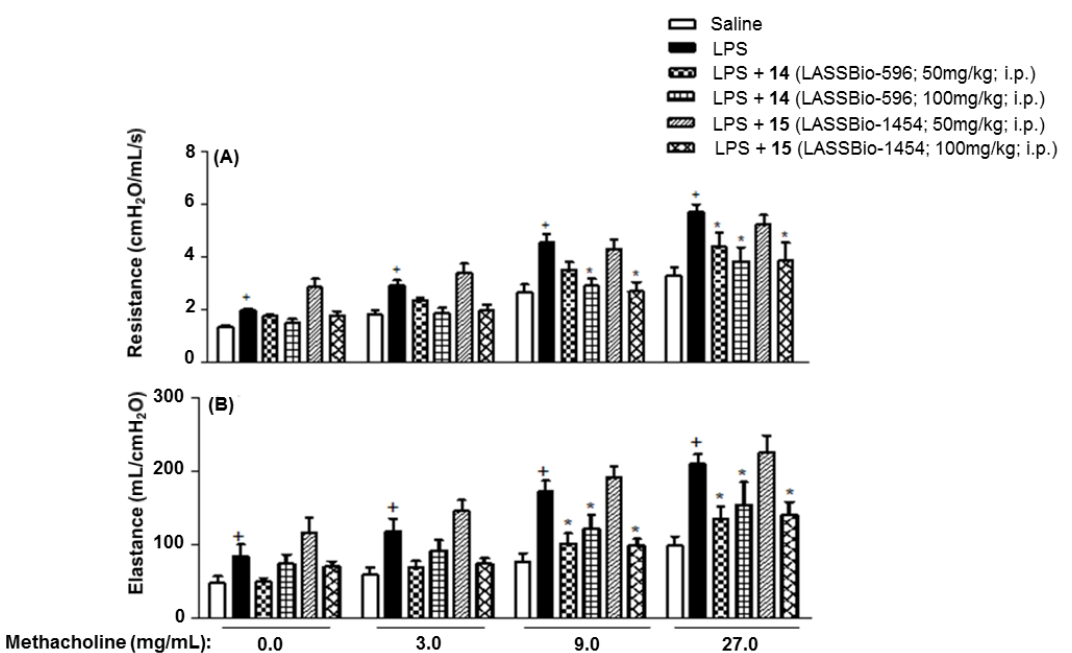
Figure 8. Effect of the carboxyamide derivatives 14 and 15 (50 and 100 mg/kg; i.p.) on methacholine-induced increase of lung resistance ( A ) and elastance ( B ) in mice stimulated with LPS (25 μ g/animal, i.n.). Values are mean ± SEM from six animals. + p < 0.05 as compared with saline group; * p < 0.05 as compared with the group stimulated with LPS; ANOVA followed by Newman-Keuls Student